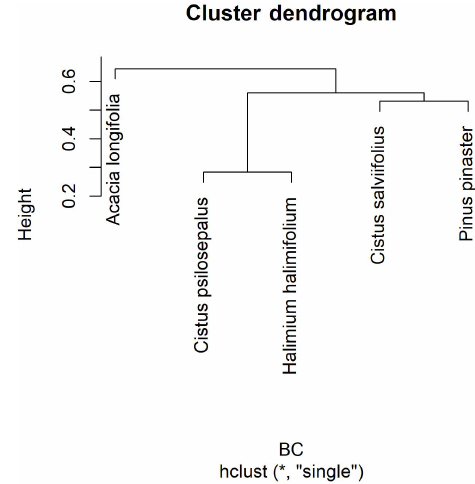
Figure 2. Cluster dendrogram using average linkage between groups, given by the Bray–Curtis dissimilarity index matrix. The y axis shows rescaled distance cluster